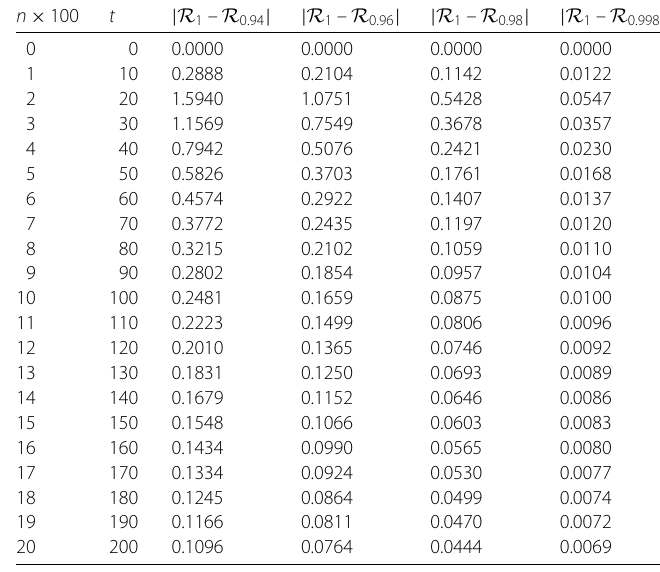
Table 10 The values of | R 1 – R φ | for φ = { 0.94,0.96,0.98,0.998